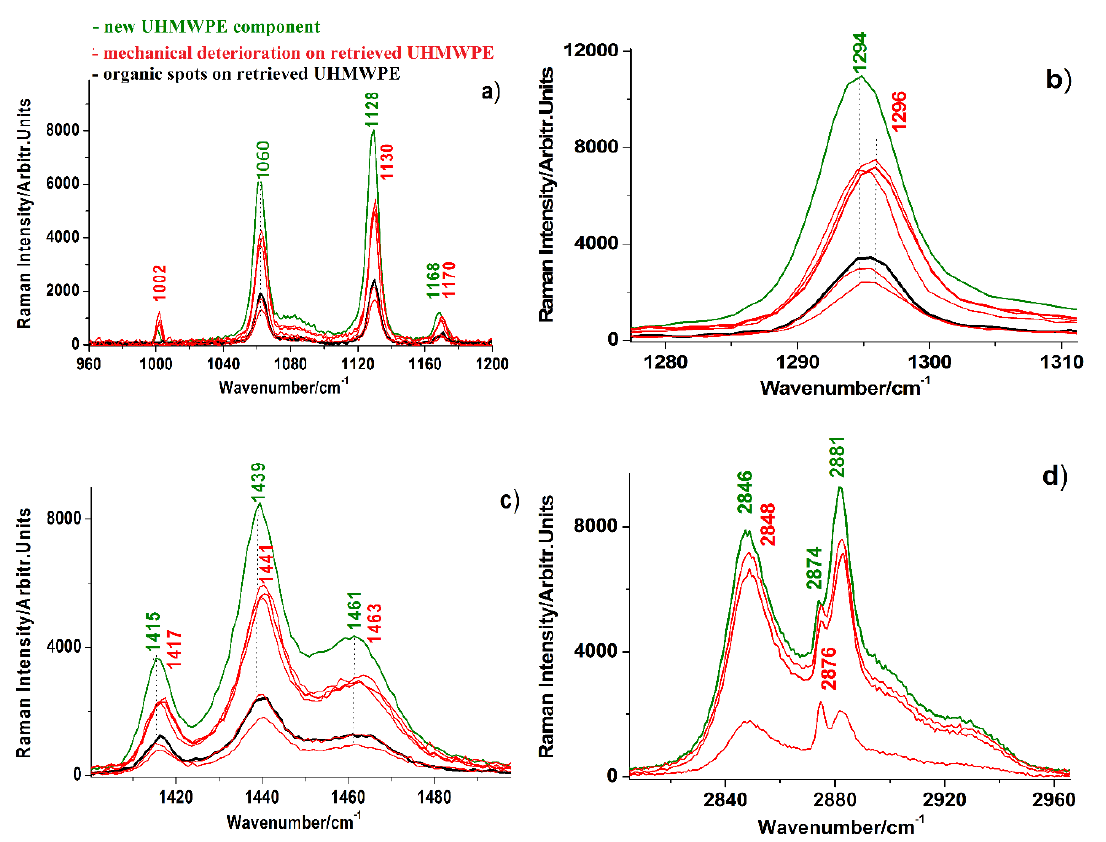
Figure 4. Micro-Raman spectra acquired from the surface of plastic (UHMWPE) component of a new (green spectra) and retrieved (red) knee prosthesis, showing the vibrational changes (band shifts, relative intensity change) during 10 years aging in human physiological environment. The details of significant intervals are shown in ( a ) 960–1200 cm − 1 , ( b ) 1280–1310 cm − 1 , ( c ) 1400–1500 cm − 1 and ( d ) 2820–2960 cm − 1 spectral ranges. Spectra acquired under similar excitation and optical collection conditions (excitation: 785, 30 mW, 10 s acquisition, 1 accumulation, 20 × objective). Multiple spectra